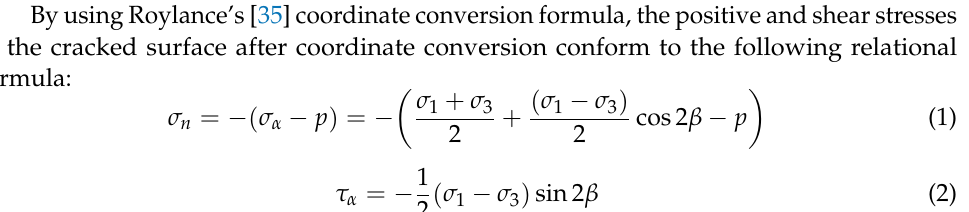
Figure 1. Schematic diagram of the stress analysis of fractured rock mass values, A is the mechanical analysis at the fracture’s middle position, B is the mechanical analysis at the fracture endnote.